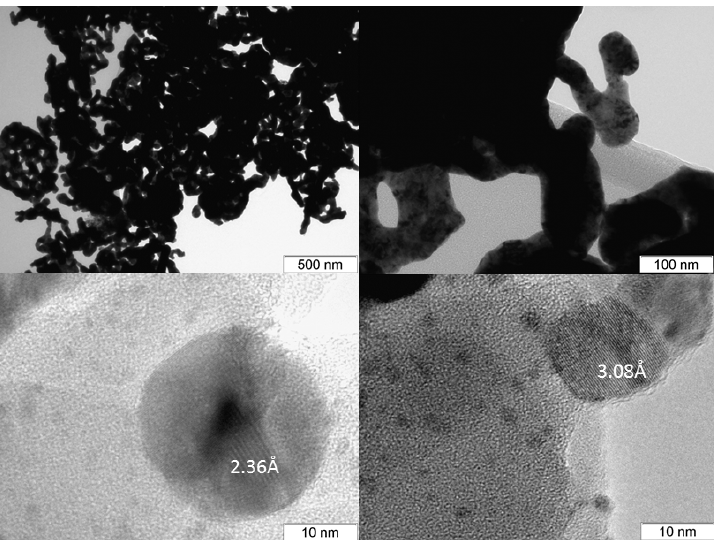
Figure 8. Micrographs of a sample obtained by decomposition of Ag 2 [PtCl 6 ] in a hydrogen at-